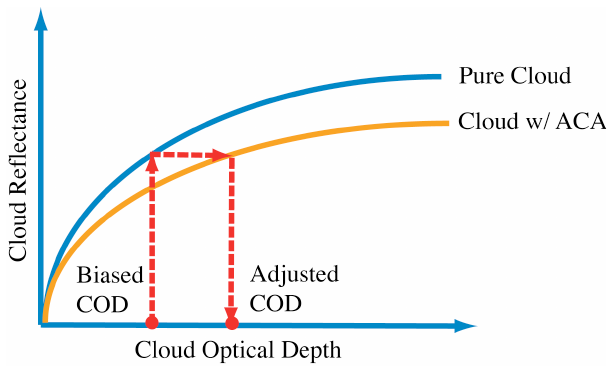
Figure 2. A schematic illustration of our fast scheme to correct the COD retrieval bias in the MODIS cloud product due to overlying aerosol